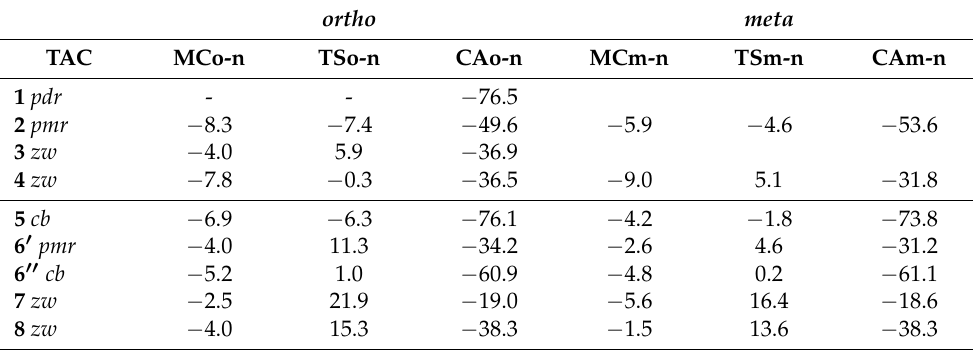
Table 4. MPWB1K/6-311G(d,p) gas phase relative electronic energies, in kcal · mol − 1 , with respect to the separated reagents, of the stationary points involved in the 32CA reactions of TACs 1 – 8 with DCE 10